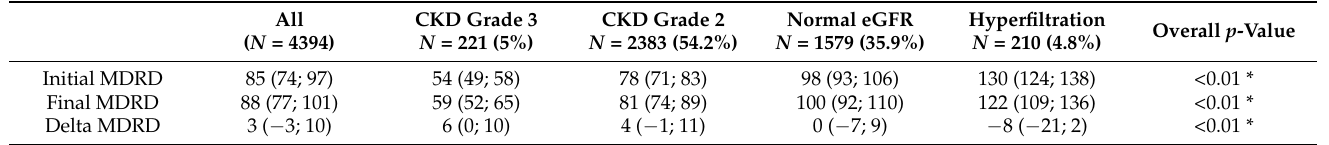
Table 3. Evolution of MDRD measures over time (final measure—initial